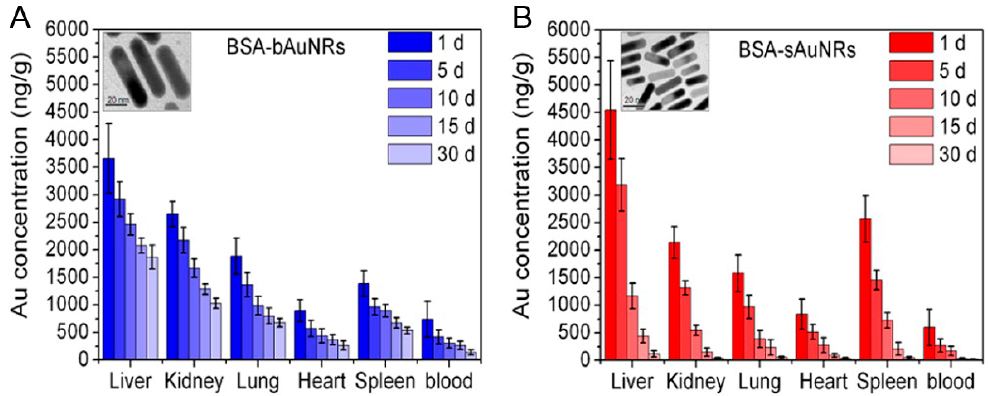
Figure 14. In vivo biodistribution and clearance of ( A ) BSA-bAuNRs and ( B ) BSA-sAuNRs together with Au concentrations at the different time points of 1, 5, 10, 15, and 30 days after intravenous injection (5 mg Au/kg). The inset are typical TEM images of the bAuNRs and sAuNRs, respectively [34].